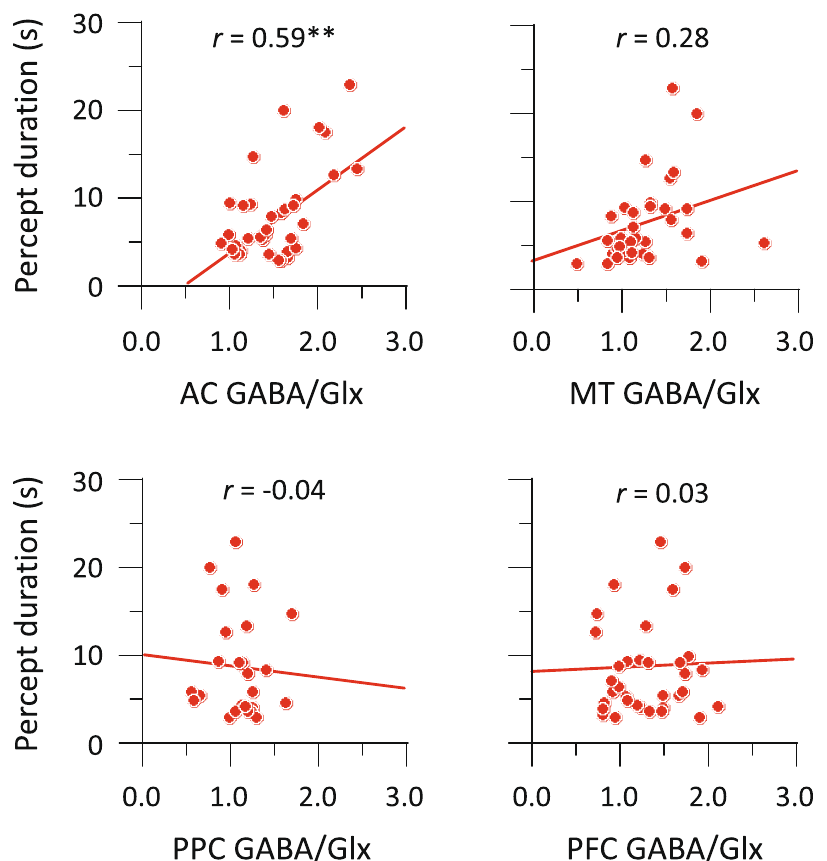
Figure 4. Correlations between MRS and behavioural results in auditory streaming. Scatter plots with linear regression fit for the relationship between GABA/Glx ratios and median percept durations. Circles indicate individual data under the Neutral conditions. ** p <